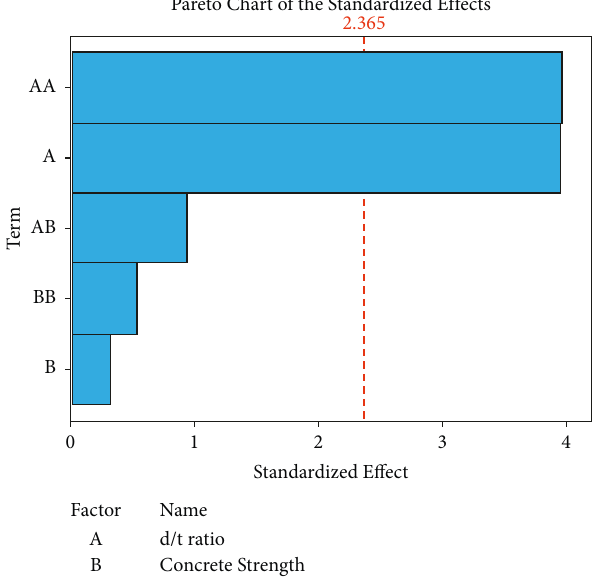
Figure 5: Pareto chart examination of the effect of D/t ratio and concrete strength on column